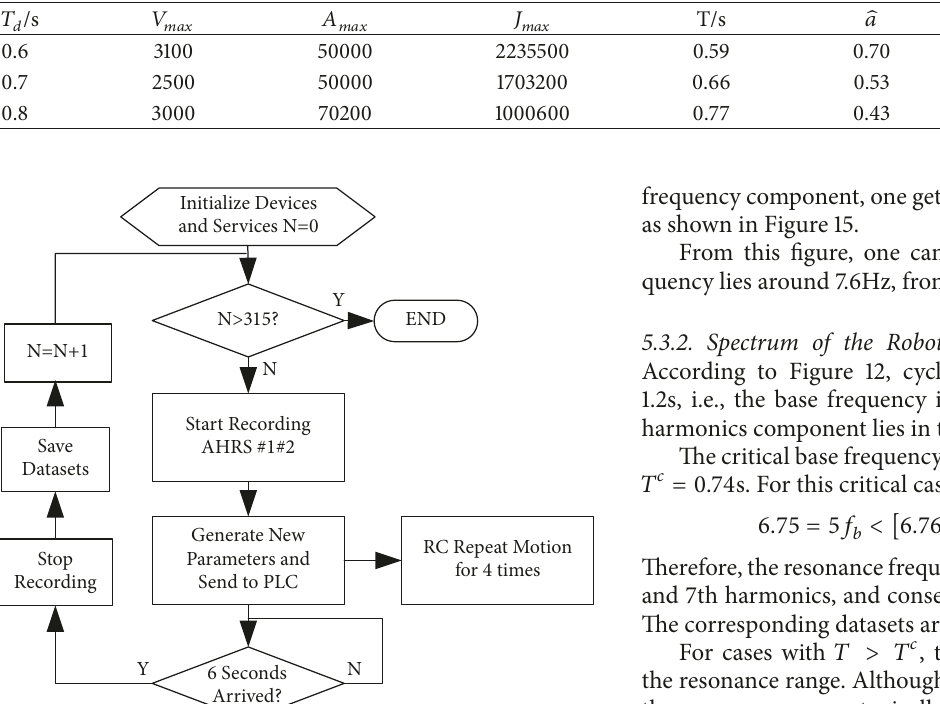
Figure 9: The vibration measurement platform. Table 2: The optimized dynamic parameters.